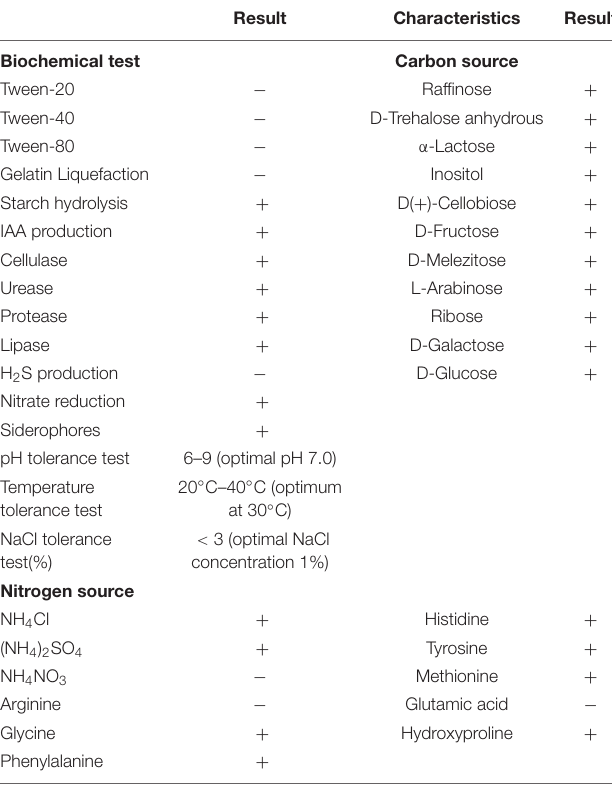
TABLE 1 | Determination of physiological and biochemical properties of S. malaysiensis